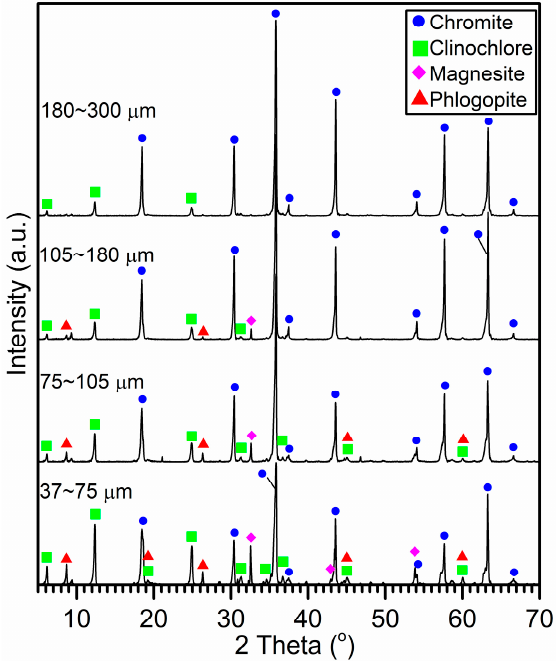
Figure 1. XRD patterns of the chromite ore of four size fractions.